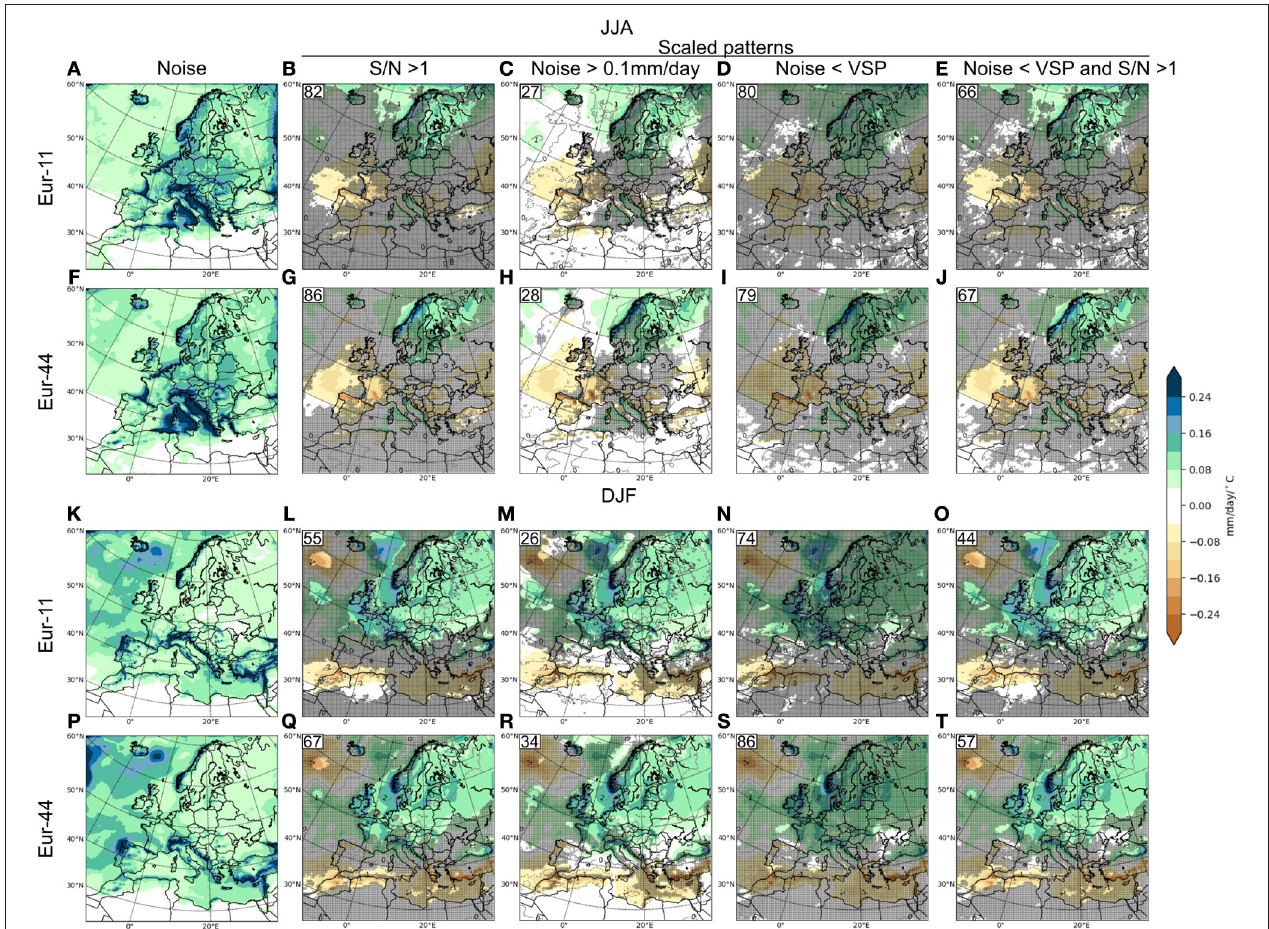
FIGURE 12 | Inter-member noise (A,F,K,P) of the 2080–2099 scaled precipitation patterns where different thresholds have been used: (1) S/N > 1 (B,G,L,Q) , (2) considering only grid points with Noise > 0.1mm/day (C,H,M,R) , considering only grid points with Noise < VSP (D,I,N,S) and (4) considering only grid points with S/N > 1 together with Noise < VSP (E,J,O,T) . The results are shown for JJA and DJF ( A–J and K–T , respectively) and both resolutions for absolute precipitation. The contour lines show the S/N ratio and the gray shading depicts “low-trust” areas defined by the metric selected. In the upper left corner of each figure, the percentage of shaded grid points is